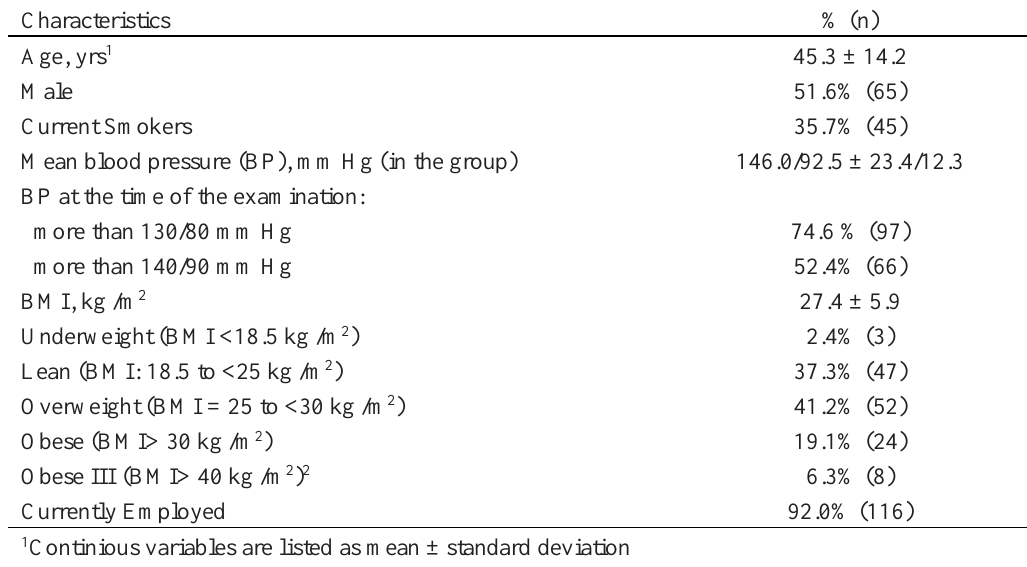
Table 1. General characteristics of study participants available for Trans-Baikal’s rural and remote